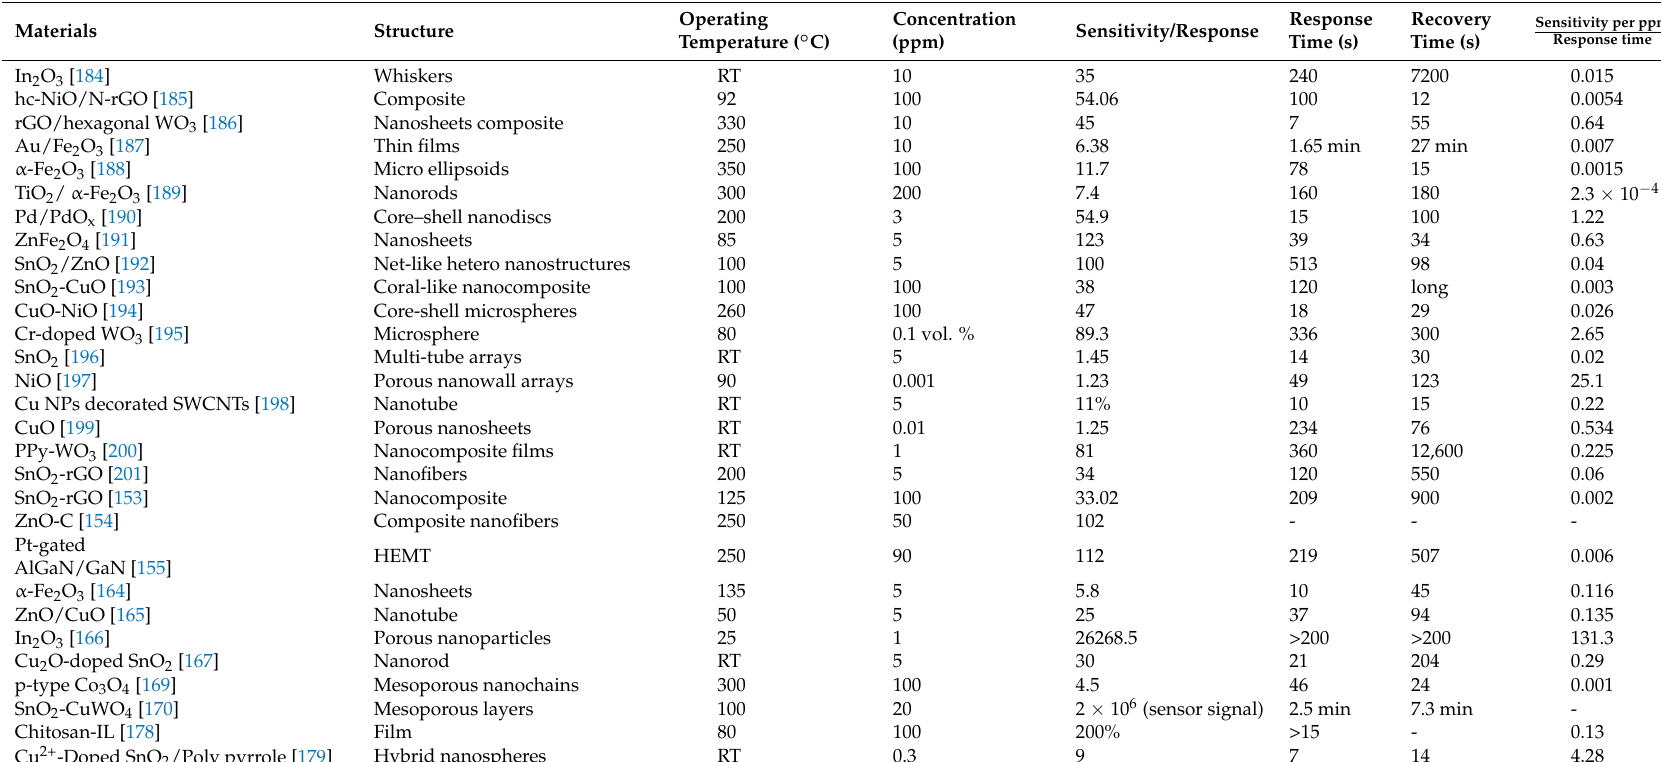
Table 3. Gas sensing properties of recently developed H 2 S gas